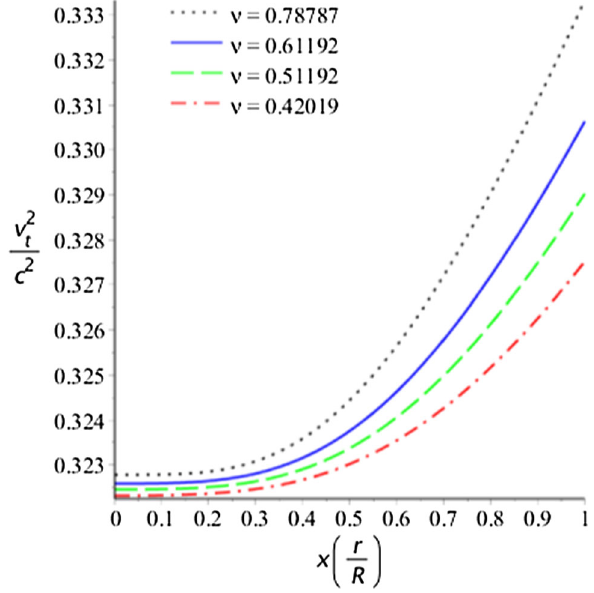
Fig. 7 Graphical representation of the tangential speed of sound for w = − 0 . 9 Table 1 Values of the hydrostatic variables for the star